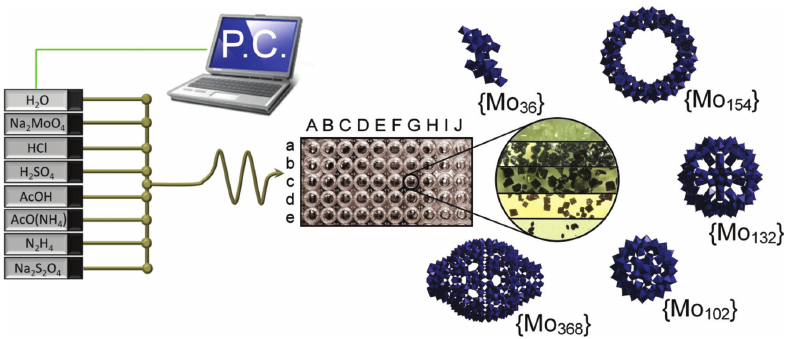
Figure 4 Schematic of the pump set-up showing reactor tubing connectivity and computer-aided control (left). Representative image of the 5 × 10 reaction array outputs produced during the discovery experiment runs (middle). Images of the crystal batches and polyhedral repre- sentations for the target polyoxomolybdates obtained; {Mo36}, {Mo154}, {Mo132}, {Mo102} and {Mo368} (right). Reprinted with permission from Macmillan Publishers Ltd [4], copyright (2012).